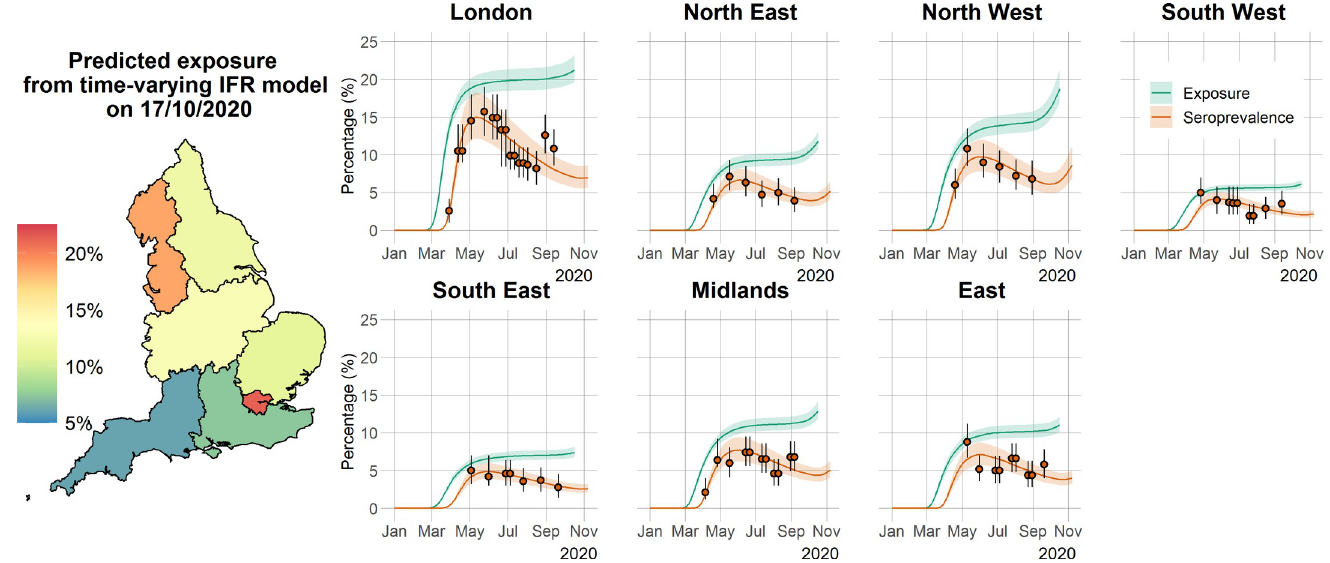
Fig 3. Time course of the SARS-CoV-2 pandemic up to 7 November 2020 for the seven regions in England in the time-varying IFR model. The orange solid circles and black error bars in each regional panel represent the observed seroprevalence data and their credible intervals after adjusting for the sensitivity and specificity of the antibody test. The green and orange lines show the median time-varying IFR model predictions for exposure and seroprevalence, respectively, while the shaded areas correspond to the 95% CrI. The regional median predicted exposure levels (expressed as the proportion of the population that has been infected) as of 17 October 2020 are shown on the map of England. The map base layer was obtained from: https://opendata.arcgis.com/datasets/ 8d3a9e6e7bd445e2bdcc26cdf007eac7_4.geojson.